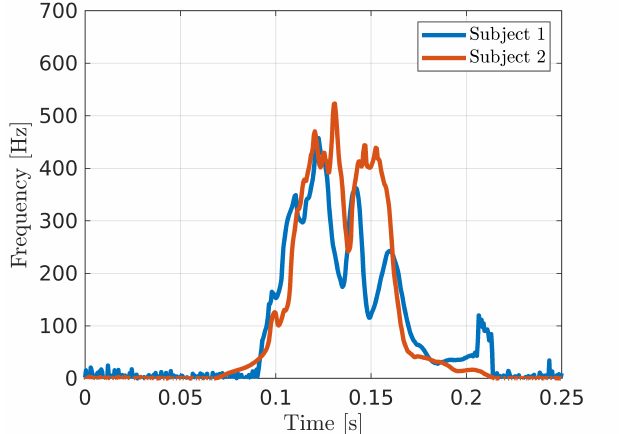
Figure 3. Instantaneous frequency of the first IMF of the received signal in case of two subjects executing the same